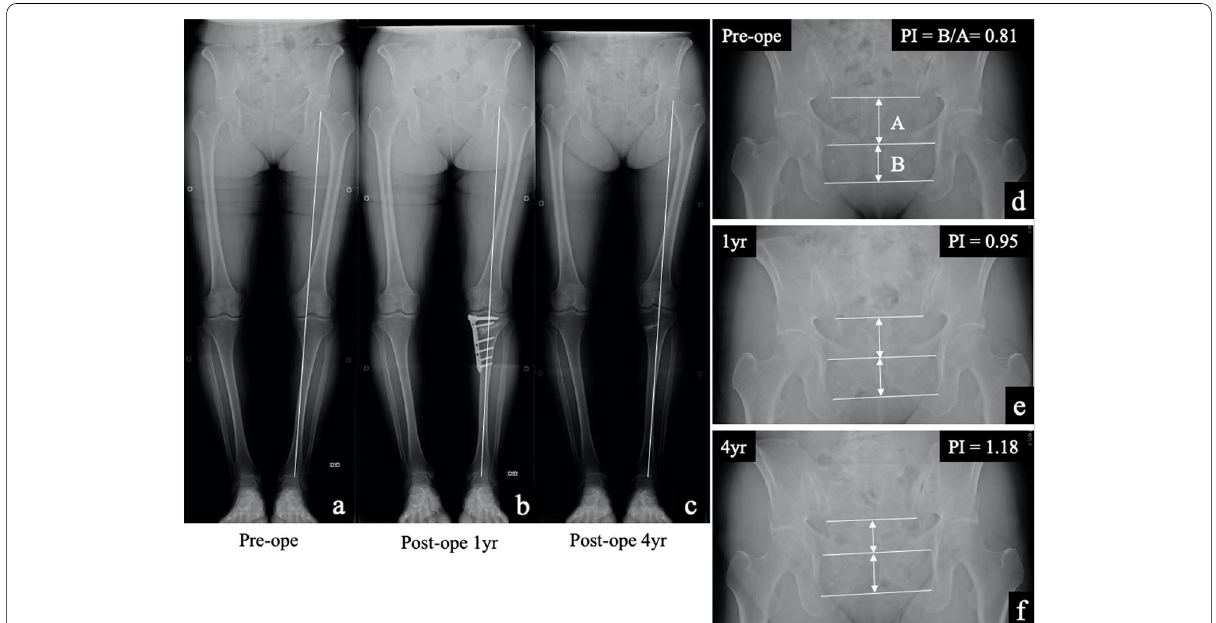
Fig. 2 The pelvic inclination ratio. a-c Representative changes in pelvic inclination are shown. Representative whole-leg radiographs, in standing, are shown for a 78-year-old woman at the following time points: preoperatively and at 1 and 4 years after OWHTO, and at the final follow-up assessment. d-f Pre- to postoperative changes in the PI ratio are shown. The preoperative PI ratio of 0.81, 0.95 at 1 year after OWHTO and increased to 1.18 at the final